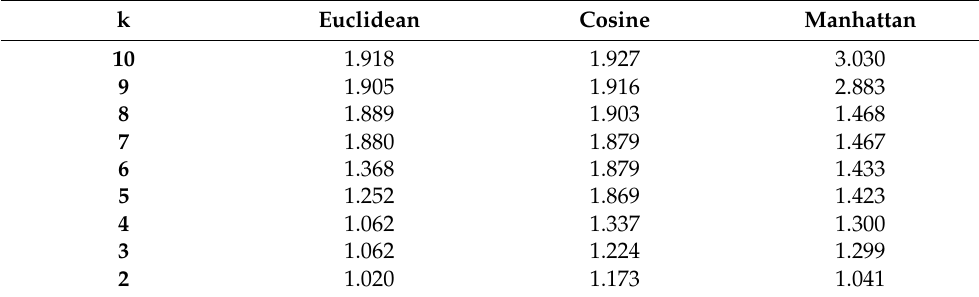
Figure 7. Hierarchical clustering dendrograms, obtained using the Euclidean ( left panel), Cosine ( center ) and Manhattan ( right ) metrics and the average linkage method. The vertical axes report the values of the metric. From these dendrograms, one can observe the tendency of the considered clustering algorithms to create highly uneven partitions at any cluster number. Table 1. IPR values of the partitions returned by hierarchical clustering algorithms, based on the Euclidean, Cosine and Manhattan metrics, at different cluster numbers k